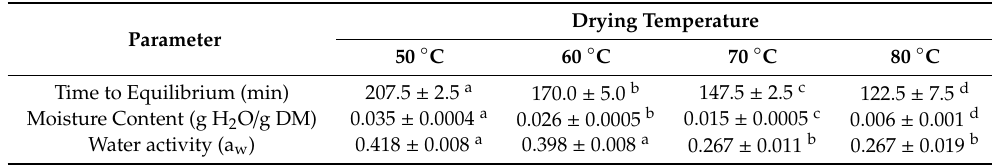
Table 2. Time taken for dried pumpkin seeds to attain equilibrium, equilibrium moisture content and water activity values of dried seeds, at a fixed velocity of 2.87 m/s.